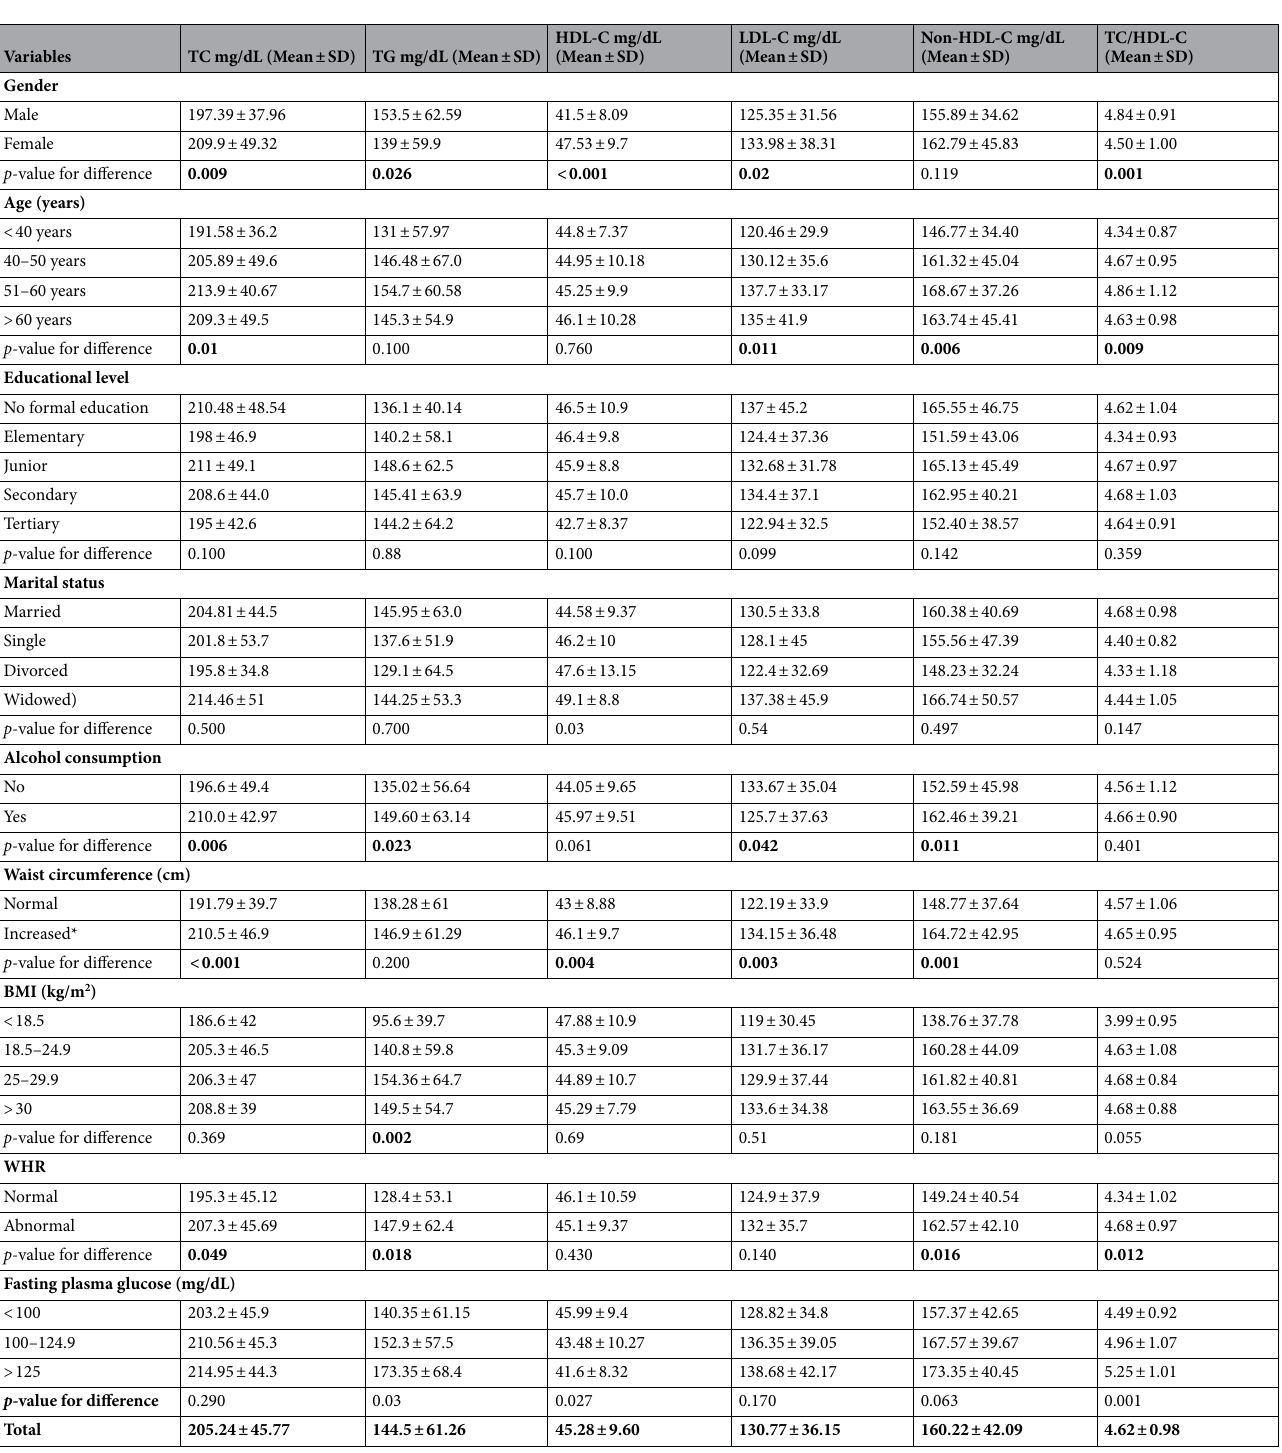
Table 2. Relationship between specific demographic characteristics, anthropometry, clinical measurements and specific lipid markers. Data are mean (standard deviation) unless otherwise indicated. Significant values are in bold. BMI body mass index, HDL-C high-density lipoprotein cholesterol, LDL-C low-density lipoprotein cholesterol, TC total cholesterol, WHR waist to hip ratio, TG triglyceride, SBP systolic blood pressure; DBP diastolic blood pressure, FPG fasting plasma